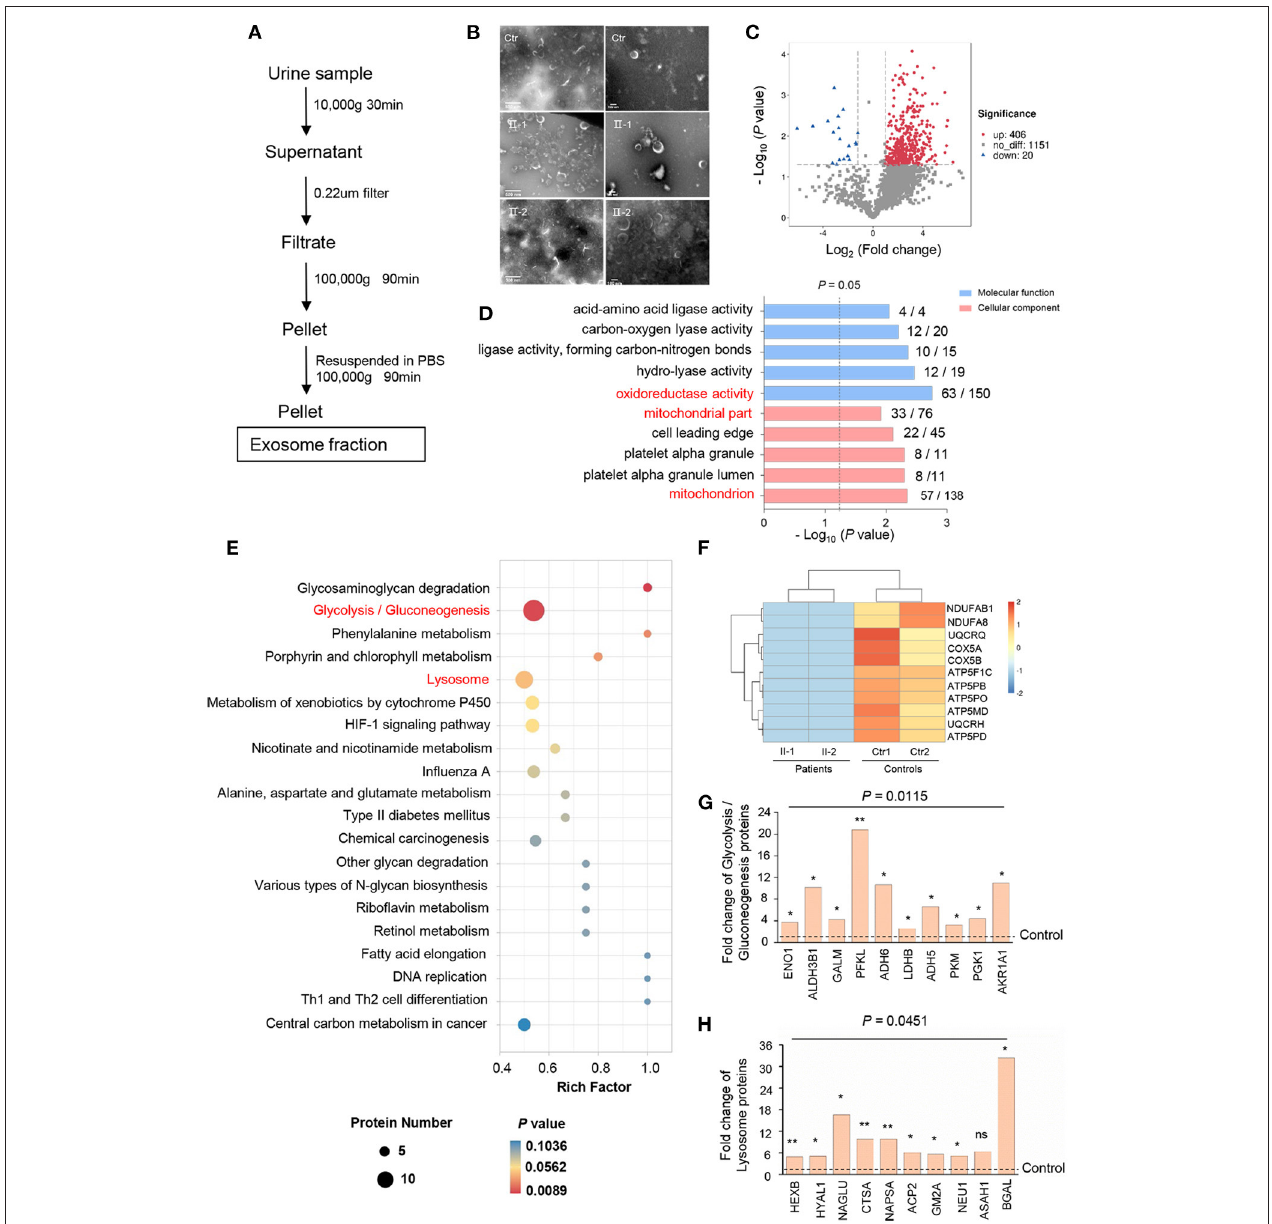
FIGURE 3 | Alterative protein profiling in urinary exosomes. (A) Isolation of urinary exosomes. (B) TEM images of exosomes from controls (Ctr) and patients (II-1 and II-2) urine. Exosomes have a cup-shaped or round “dimple” appearance. Scale bar: left, 500nm; right, 100nm. (C) Volcano plots of proteins with significant expression in patients compared with that in controls. Red points, FC ≥ 2; blue points, FC ≤ 0.5; gray, not significant. (D) GO annotation in molecular function and cellular component (ranked by –log 10 [ P -value]) using Blast2Go. The number of significantly expressed proteins and all proteins identified in each GO term were noted. (E) Analysis of urinary-exosome proteomics using the KEGG database, showing significant alteration in expression of the proteins of glycolysis/gluconeogenesis, and lysosome pathways between patients and controls. (F) Heatmap for downregulation of OXPHOS proteins in patients relative to that in controls. Eleven proteins of OXPHOS were undetectable in PKHD1- mutant samples and assigned as “ − 1”. (G, H) Fold-change of individual proteins in the pathways of glycolysis/gluconeogenesis (G) and lysosomes (H) . * P < 0.05; ** P <